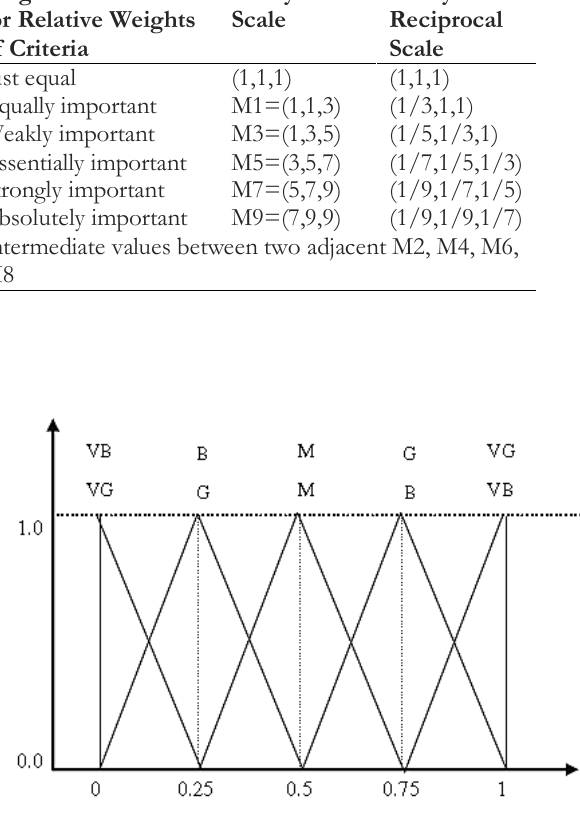
Fig. 2. Membership functions of linguistic values for criteria rating.